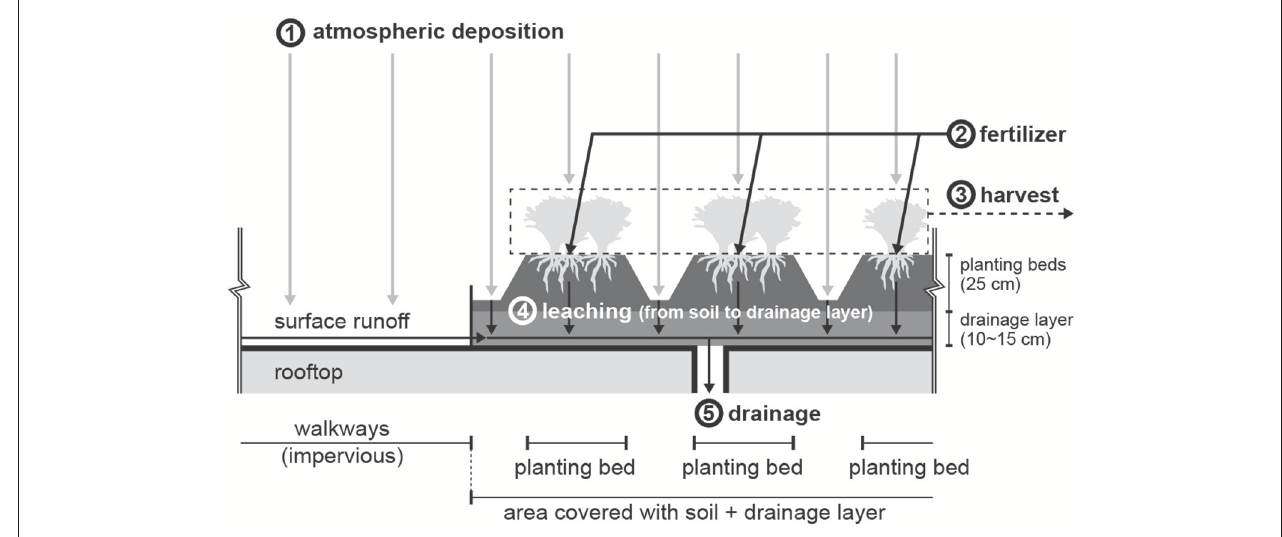
FIGURE 2 | Diagrammatic site section showing N fluxes of the Brooklyn Grange Navy Yard farm, NYC.